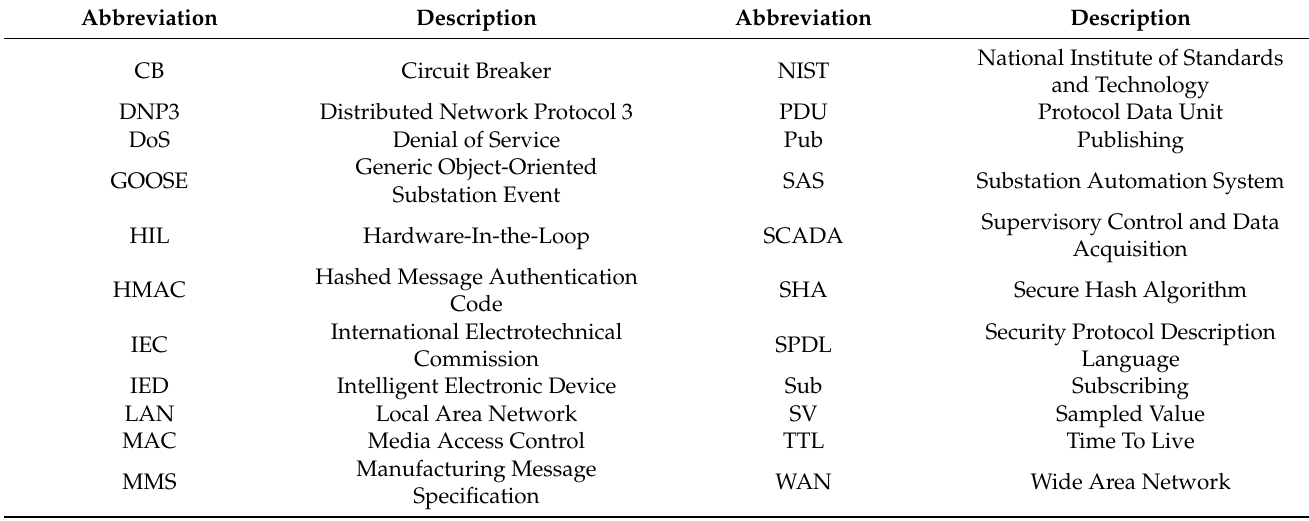
Table 1. List of